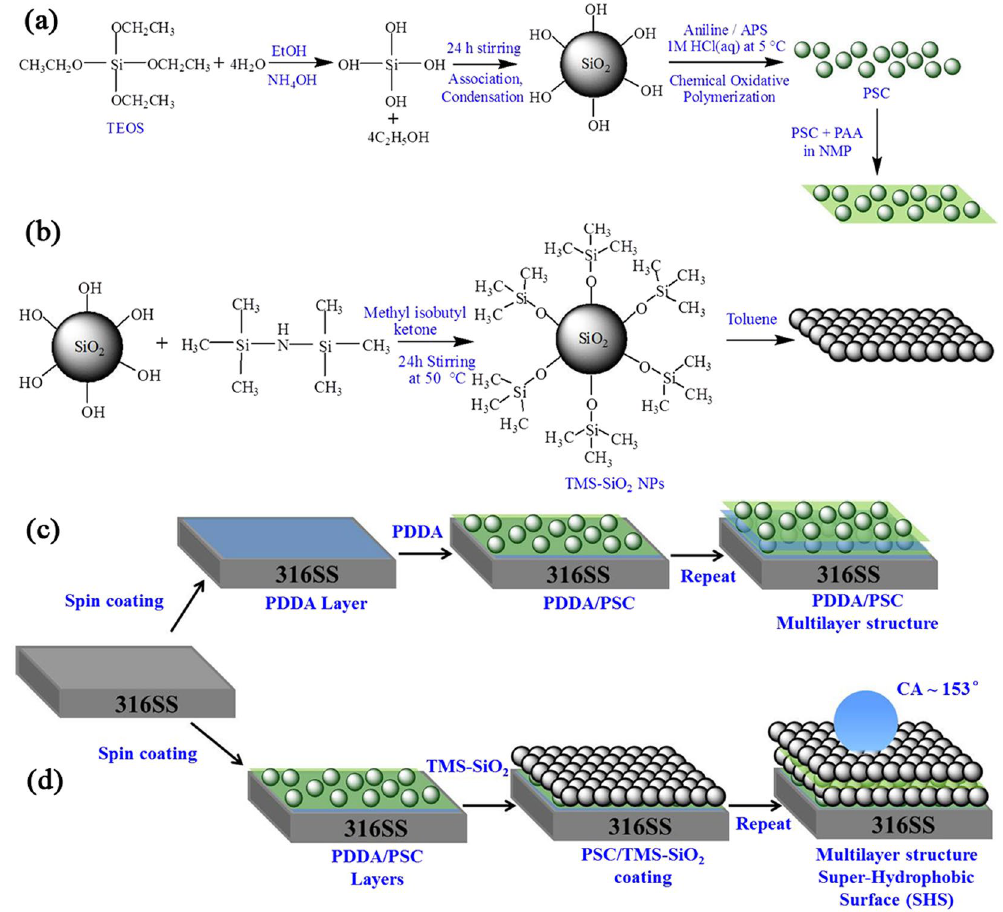
Figure 1. The schematic shows the synthesis of ( a ) PSC composite and preparation of its coating solution, ( b ) surface modification of silica to obtain TMS-SiO 2 NPs. Fabrication of ( c ) PDDA/PSC and ( d ) PSC/TMS-SiO 2 multilayers on 316SS by spin